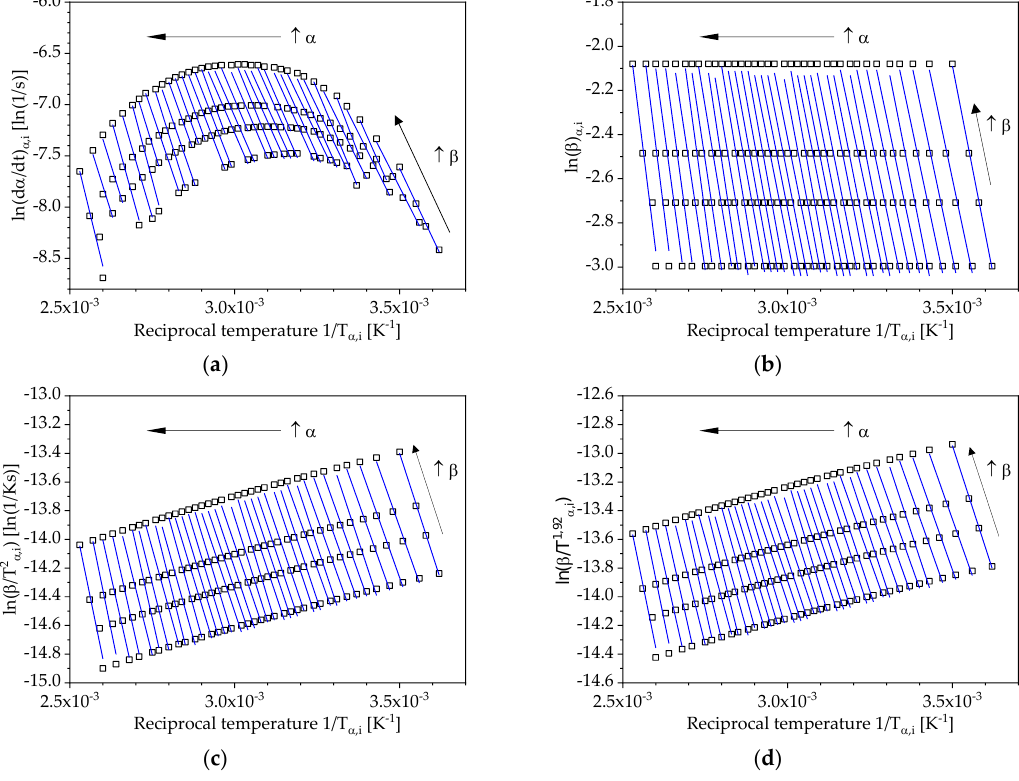
Figure 6. Isoconversional plots according to: ( a ) Friedman; ( b ) Flynn-Wall-Ozawa; ( c ) Kissinger- Akahira-Sunose; ( d ) Starink.